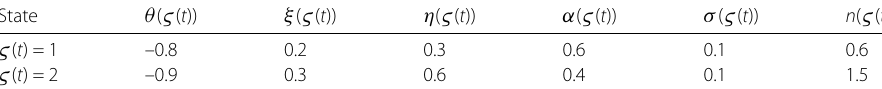
Table 3 Parameter values under finite regime switching of model (4) State θ ( ς ( t ))